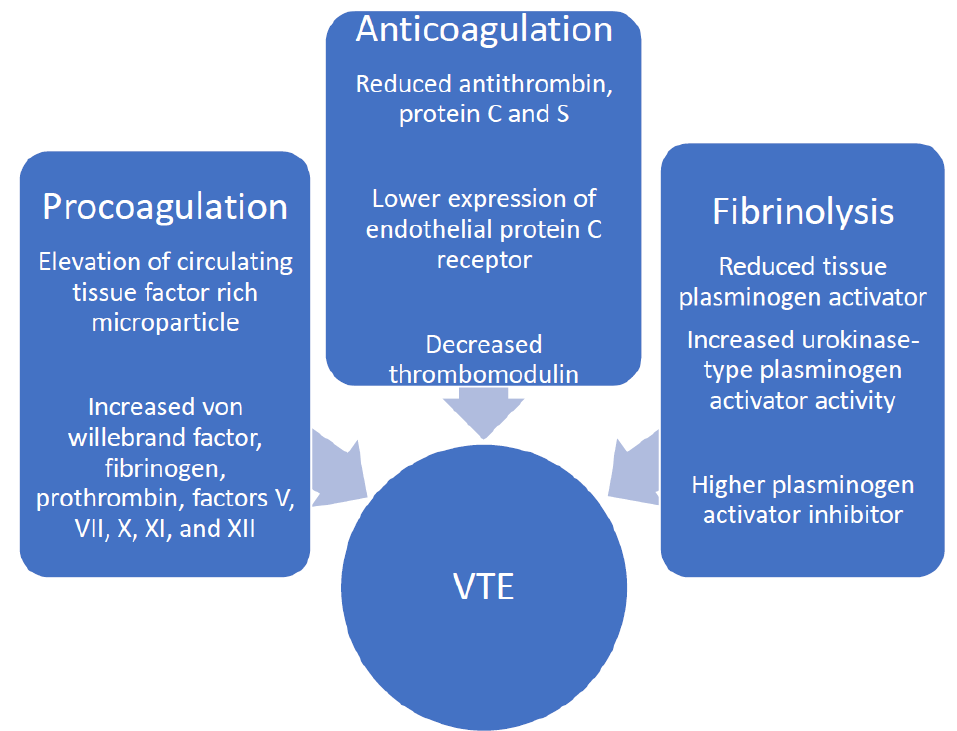
Figure 3. Coagulation abnormalities in IBD. VTE: venous thromboembolism; IBD: inflammatory bowel diseases.